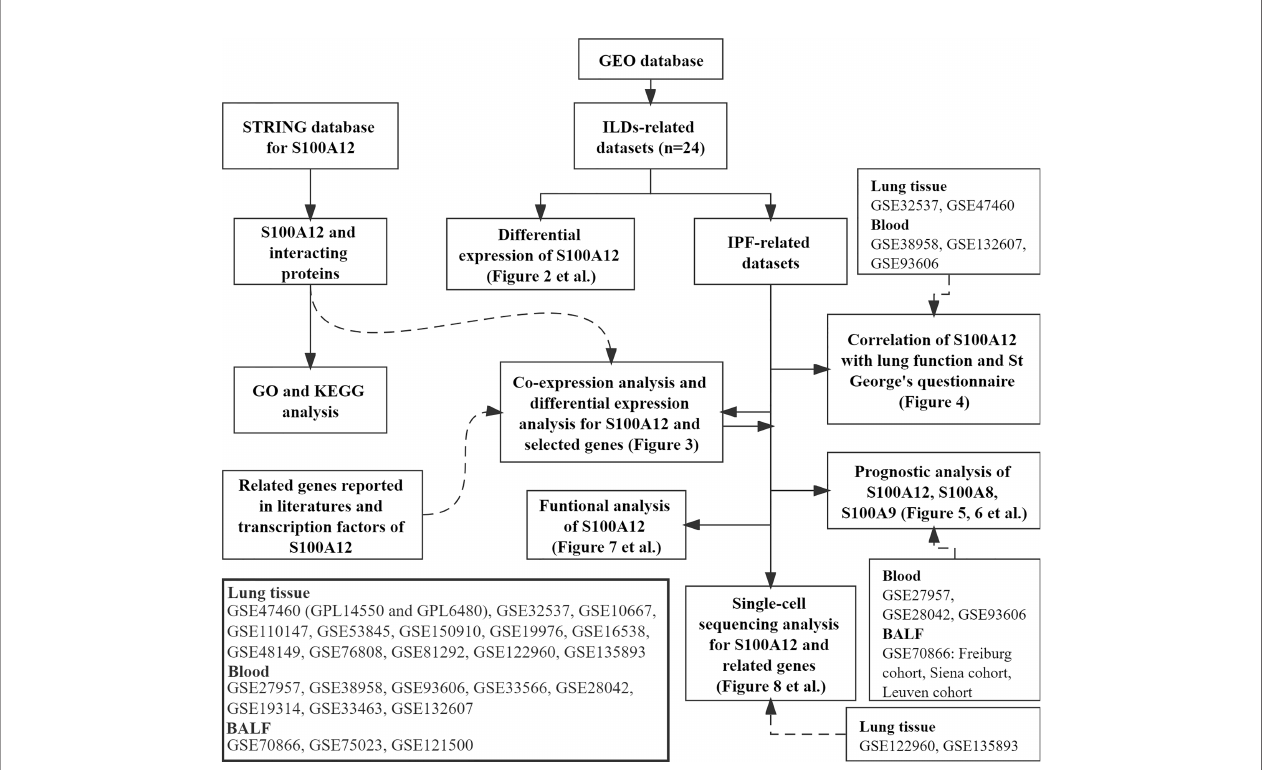
FIGURE 1 | Work fl ow of this